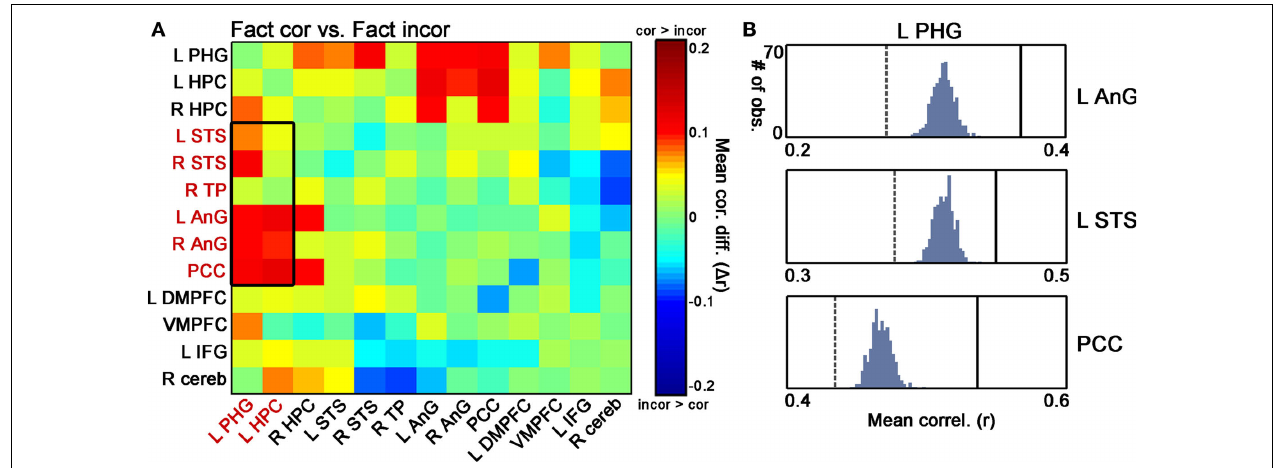
FIGURE 7 | Differential coactivation in the retrieval network as a function of retrieval accuracy, controlled for confi dence levels. (A) Matrices denoting the differences between inter-ROI correlations of Fact_cor vs. Fact_incor that were rated with low or medium confi dence. Each cell indicates the difference between mean inter-ROI correlations of BOLD responses during Fact_cor vs. Fact_incor . The rectangle outlines the